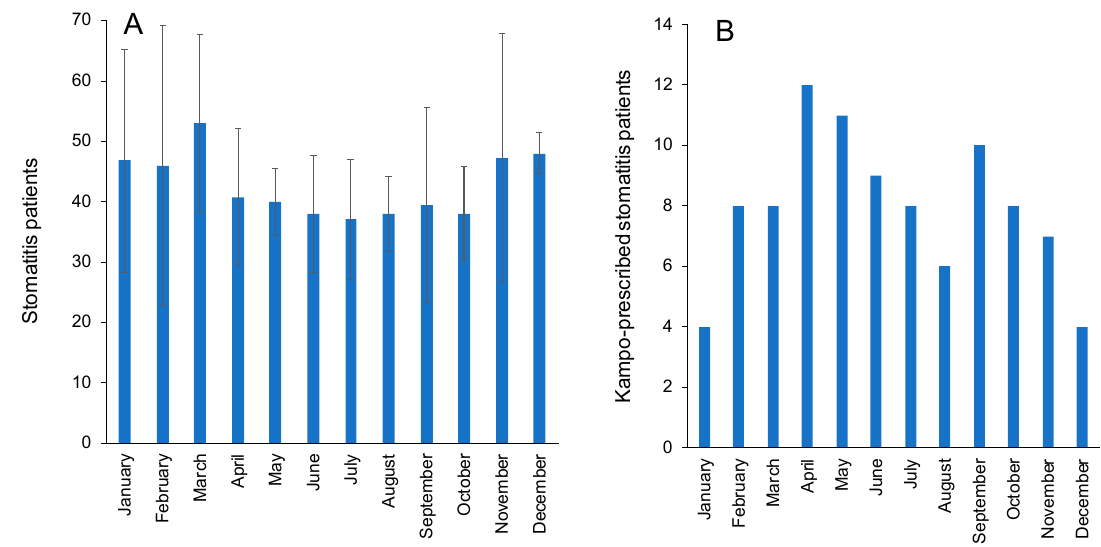
Figure 2. Number of stomatitis patients ( A ) and prescribed Kampo medicines in the hospital of Nihon University School of Dentistry ( B ). Table 1. Kampo medicines and their constituent plant extracts used for treatment of stomatitis in the hospital of Nihon University School of Dentistry. BKTN, Byakkokaninjinto; GRS, Goreisan; HKT, Hangekobokuto; HST, Hangeshashinto; SRT,